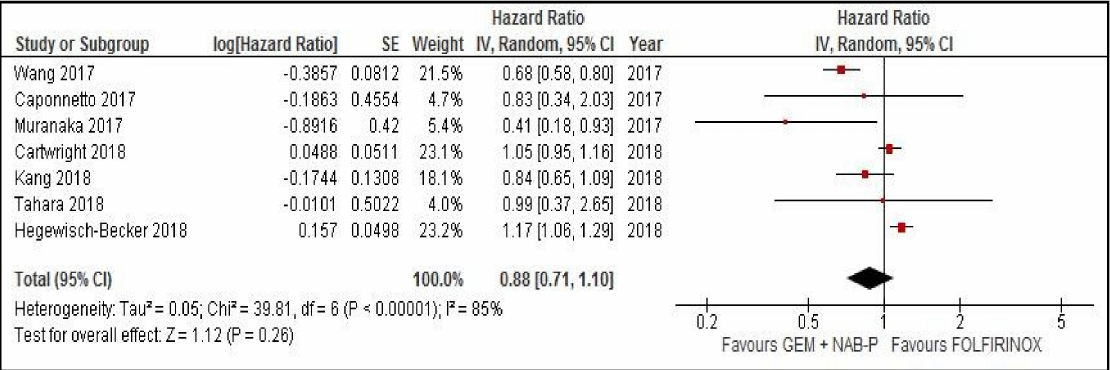
Figure 2. Progression-free survival comparison between gemcitabine plus nab paclitaxel and FOLFIRINOX. CI: confidence interval, GEM + NAB-P: gemcitabine plus nab paclitaxel, IV: interval variable, SE: standard